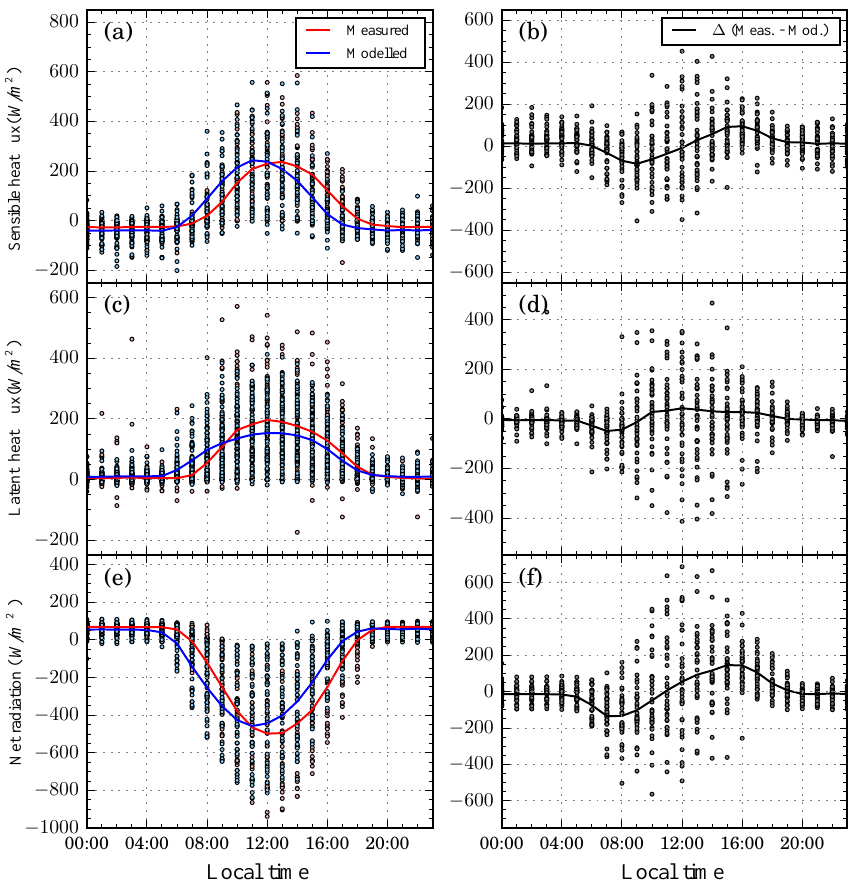
Figure 5. Hourly means for measured (circles) and modelled (triangles) for (a) sensible heat flux; (b) difference between measured and modelled sensible heat flux, as calculated over the period of 2006; 1 in every 10 days is plotted for clarity; (c) and (d) : as above for latent heat flux; (e) and (f) : as above for net radiation. Continuous lines show the overall mean.